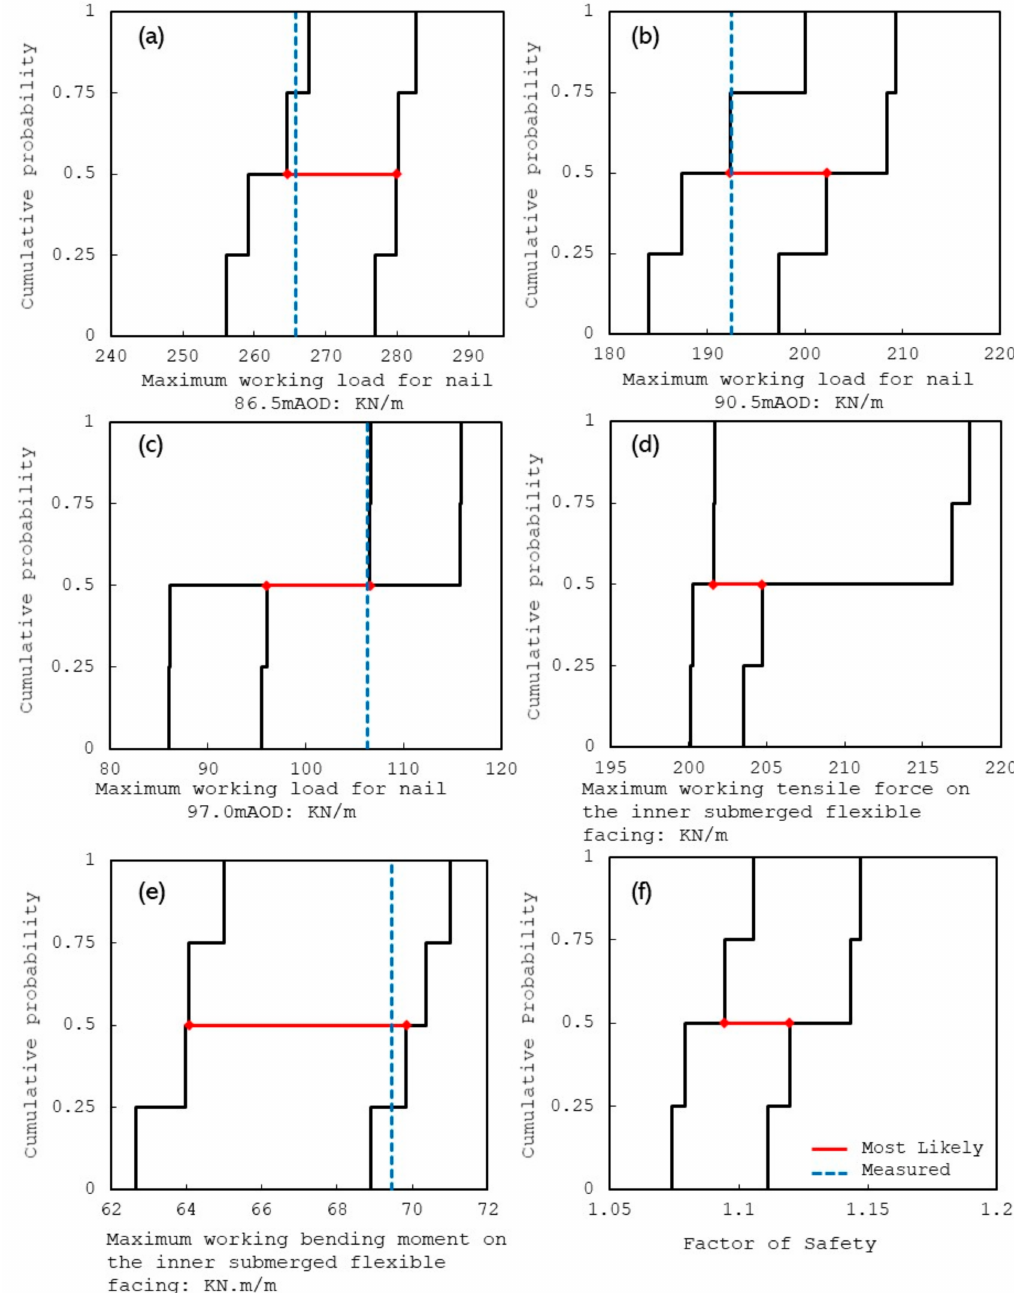
Figure 3. FHWA compliant limit states (index parameters) on RS p -Boxes and in relevance to the lower bound, upper bound, and most likely limit states in the face of uncertainty; ( a ) maximum mobilised working axial load in the eighth nail from ground level on the submerged inner wall, ( b ) maximum mobilised working axial load in the sixth nail from ground level on the middle wall, ( c ) maximum mobilised working axial load in the third nail from ground level on the upper wall, ( d ) maximum mobilised axial load along the inner submerged shotcrete facing, ( e ) maximum mobilised bending moment along the inner submerged shotcrete facing, and ( f ) global factor of